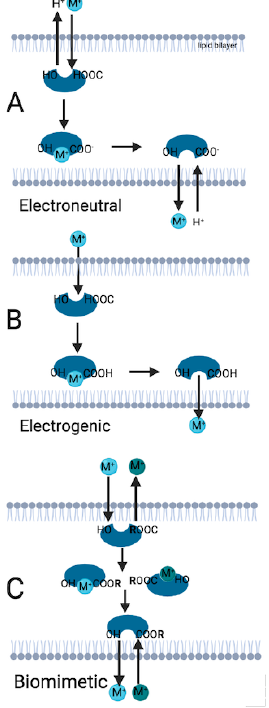
Figure 1. Ionophore transport mechanisms. ( A ): Electroneutral transport occurs when the ionophore is charged negatively because of the proton released from the carboxyl group. ( B ): In the electrogenic transport, the ionophore is uncharged, and transport occurs throughout the lipid bilayer mem- branes. ( C ): If the ionophore has an R group, biomimetic transport occurs. M: Representative